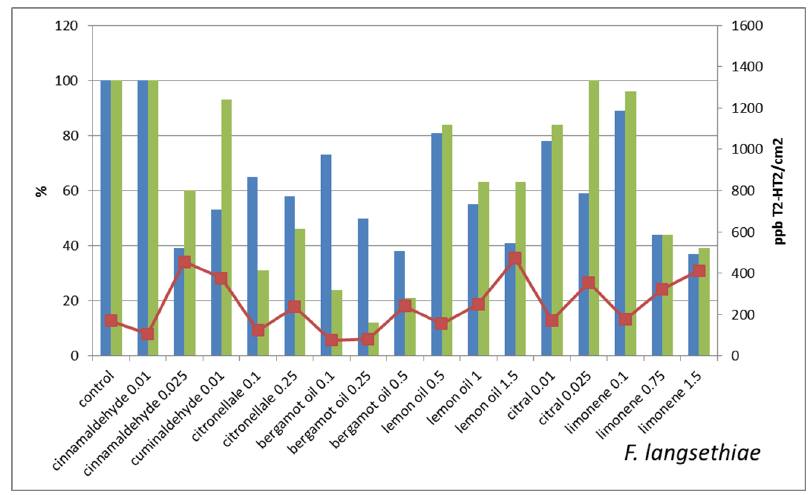
Figure 3. Impact of sub-lethal product concentrations on F. langsethiae growth and mycotoxin production. Blue bars indicate the mean values of mycelium in vitro growth (expressed as percentage of growth respect to untreated control) of Fusarium langsethiae treated with sub-lethal concentrations of the indicated natural products. Green bars represent the mycotoxin production (expressed as percentage of T-2, HT-2 respect to untreated control) and the line chart indicates the T-2, HT-2 concentration (expressed in ppb) per mycelium unit area (expressed in cm 2 ).